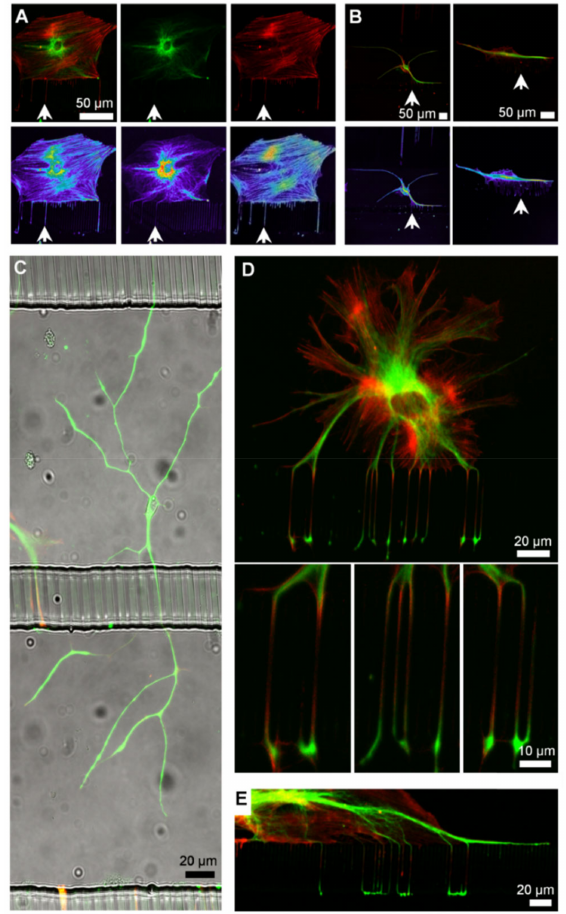
Figure 7. Compartmentalization of glia in microfluidic channels. ( A , B ) Glial cells cultured in contact with E-PDMS microfluidics develop cellular branches that extend through interconnects. Antibodies for glial fibrillary acidic protein (green) and rhodamine phallotoxins (phalloidin, red) label the cy- toskeleton. Fluorescence intensities of cell branches are represented by glow-scale intensity images (below). Fine, filamentous glial branches are rich in filamentous actin and contain GFAP filaments. Filamentous cellular protrusions of glia extend through the microfluidic channels (white arrow). ( B ) Merged fluorescence images of two glial cells are shown, each in its own image pane. ( C ) Large (~400 µ m long), ramified glial cells do not show affinity for channel sidewalls and interconnects as most glial cells do. ( D ) A glial cell in the top channel extends branches into the bottom channel allow- ing subcellular stimulation with signaling molecules applied through adjacent channels. Insets show magnified views of glial branches wrapping around the interconnect pillars, merging as they emerge into the bottom channel. ( E ) Glial cells often spread along the interconnect wall sending branches over distances exceeding 100 µ m, increasing the efficiency of inter-channel signal